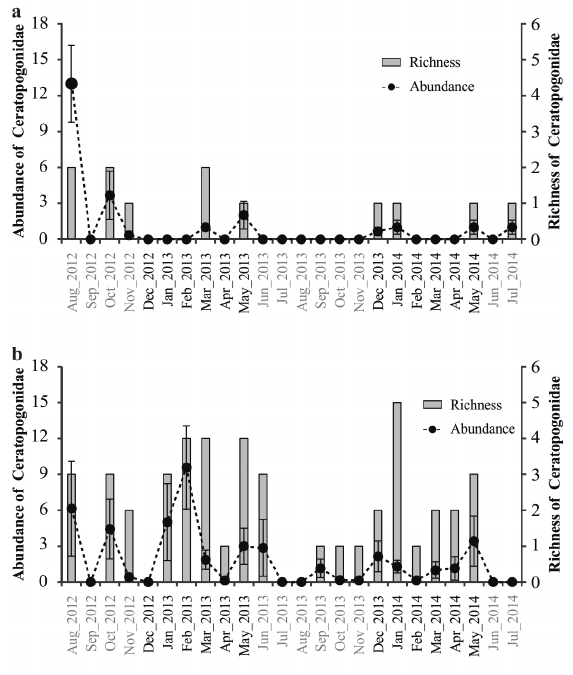
Figure 1 - Mean abundance and richness of Ceratopogonidae sampled between August 2012 and July 2014 in artificial containers located in (A) open area and (B) closed area in an urban forest fragment in Central Amazon. Sample months in black = rainy season; Sample months in gray = dry season.